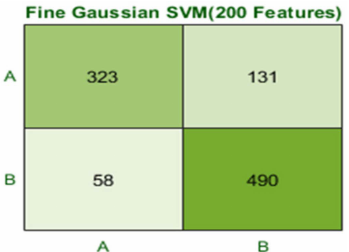
Figure 12. Confusion matrix for FG(SVM) with 200 features and using 5-fold results.